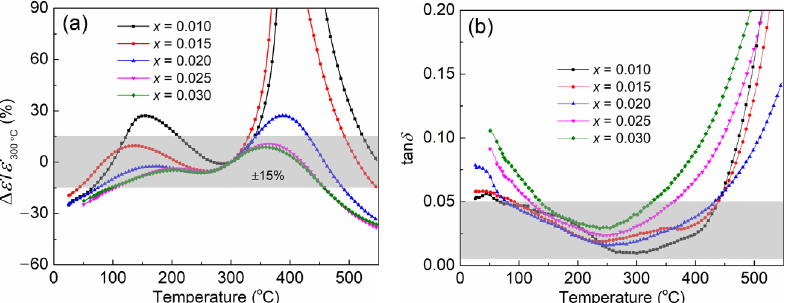
Fig. 7 Temperature variation of (a) ε ′ and (b) tan δ as a function of temperature for (1 − x )KNN– x BZN ( x = 0.010, 0.015, 0.020, 0.025, and 0.030) ceramics at 1 MHz.